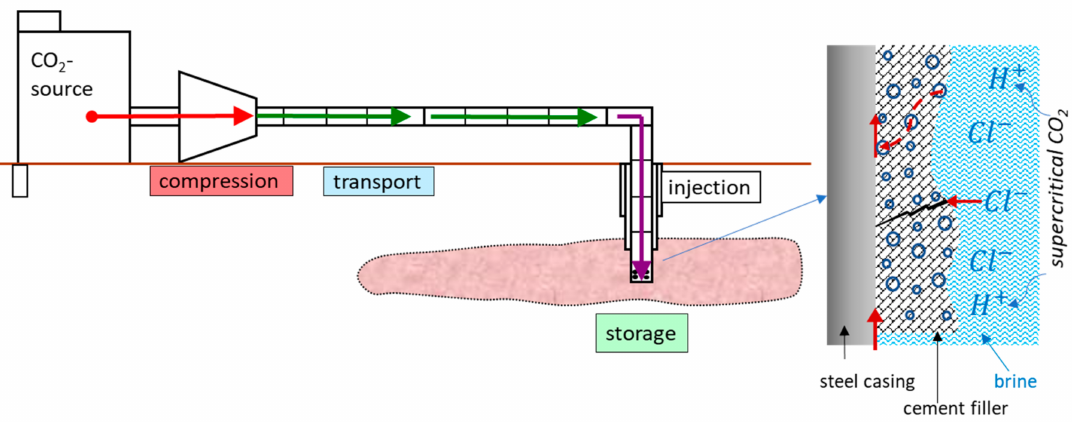
Figure 1. Sketch of the carbon capture and storage (CCS) process and possible corrosion mechanisms happening at casing steel/cement due to CO 2 -brine